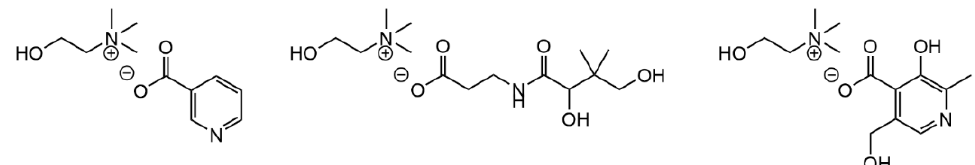
Figure 11. ILs combining the cholinium cation with the anionic forms (conjugate bases) of (from left to right) nicotinic acid (vitamin B3), pantothenic acid (vitamin B5), and pyridoxic acid (vitamin B6 co-factor), reported by Chantereau et al. [146]. Adapted with permission from ref. [146]. Copyright 2020 Elsevier.